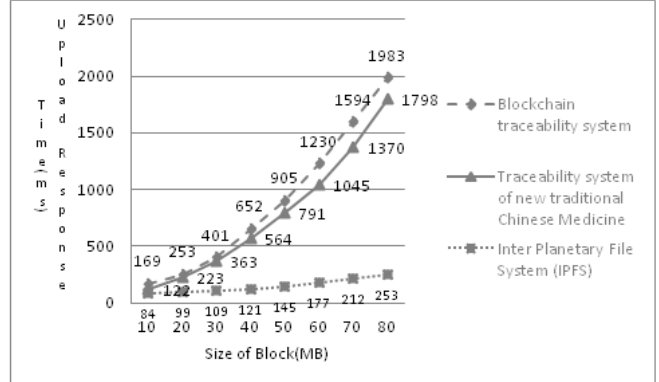
Figure 6. Comparison of the upload response times with different sizes of block storage.